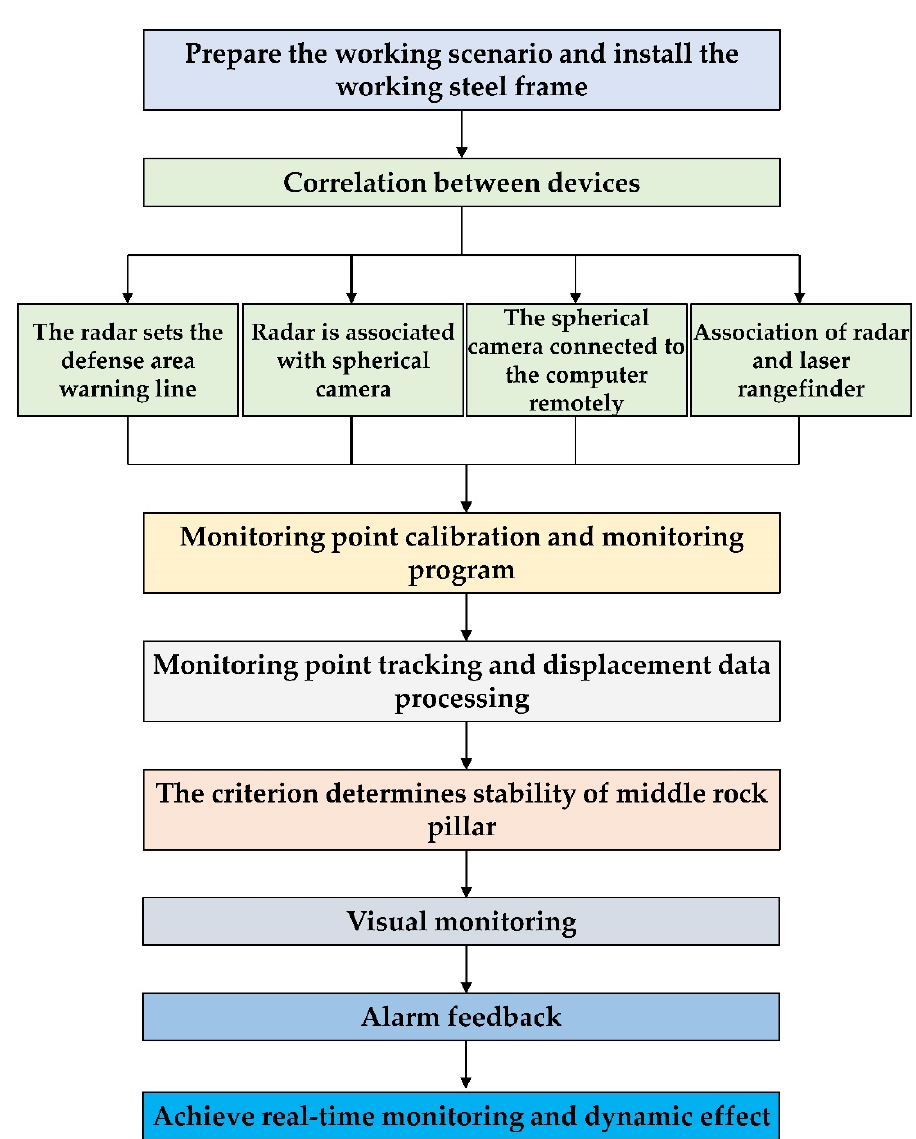
Figure 12. Workflow of automatic monitoring and control of middle rock pillar.